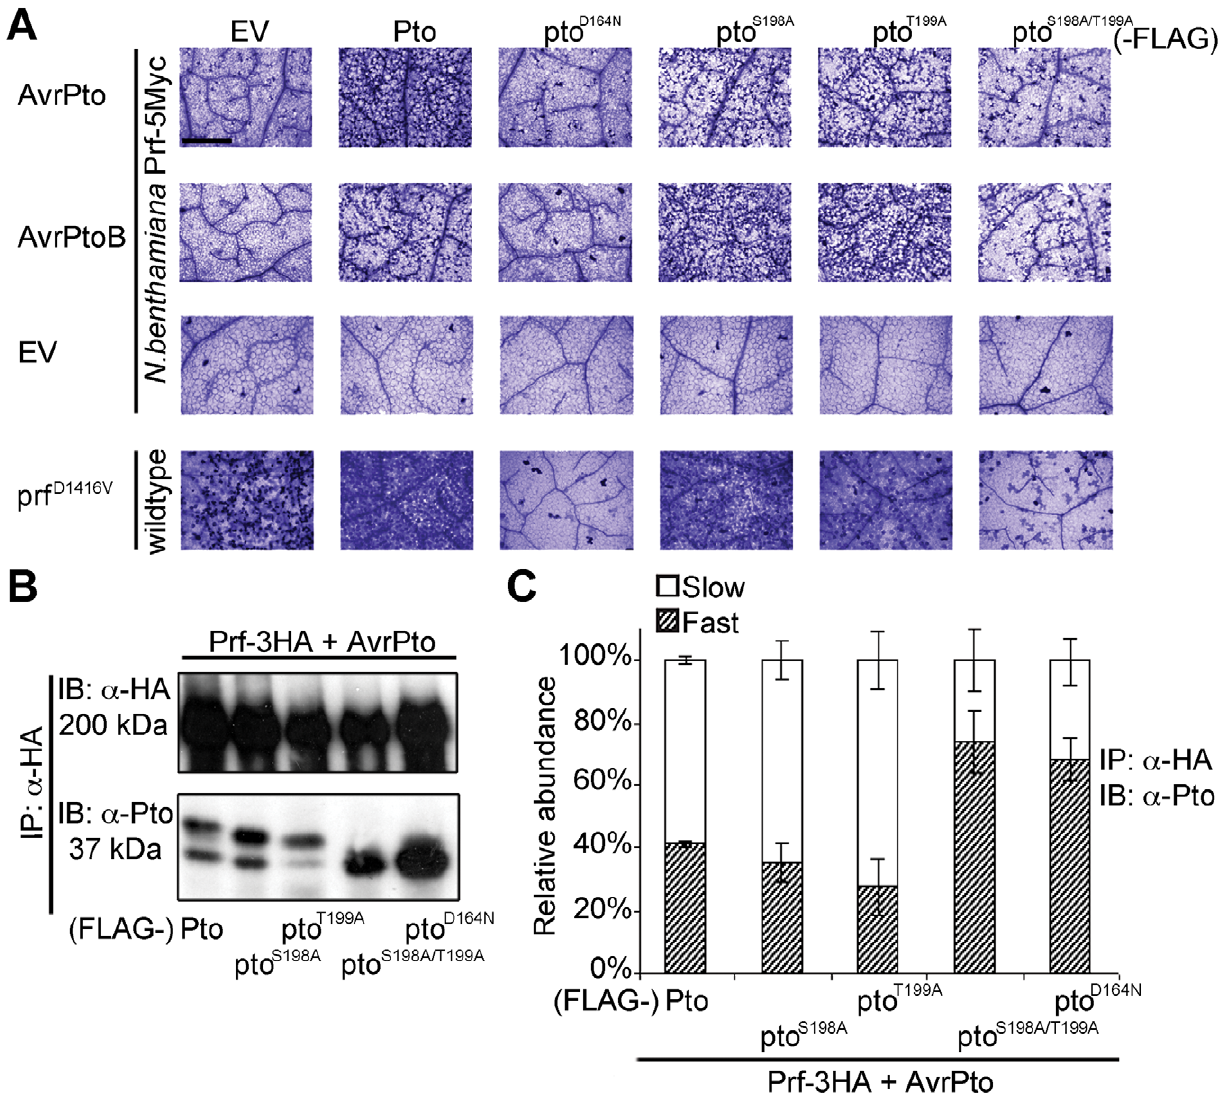
Figure 2. Phosphorylation on Pto residues S198 and T199 is required for signalling. ( A ) Trypan blue staining of cell death in N. benthamiana leaves. Pto-FLAG, pto mutant-FLAG, AvrPto, AvrPtoB, and prf D1416V -3HA constructs were transiently expressed in Pro Prf : Prf-5Myc or wild- type N. benthamiana as indicated and the tissue was stained 2 days post infiltration. The bar indicates 0.5 mm. Dead cells stain dark blue in this qualitative assay. Each row is derived from a single leaf, within which relative amounts of cell death were comparable, and is representative of six replicates. ( B ) The slow-migrating form of Pto requires kinase activity and double phosphorylation. Pto-FLAG, pto mutant-FLAG, AvrPto, and Prf-3HA constructs were transiently expressed in wild-type N. benthamiana as indicated, Prf-3HA was immunoprecipitated (IP) using anti-HA antibodies. Immunoblots (IB) were performed with the antibodies indicated on the left. ( C ) Quantification of the relative abundance of slow- and fast-migrating forms of Pto under elicitation conditions as described in B with Quantity One, Bio-Rad (adjusted volume=[CNT*mm2] data counts/mm 2 ). Error bars are standard deviation of relative abundance between the same samples in independent immunoblots, probed with anti-Pto antibody.